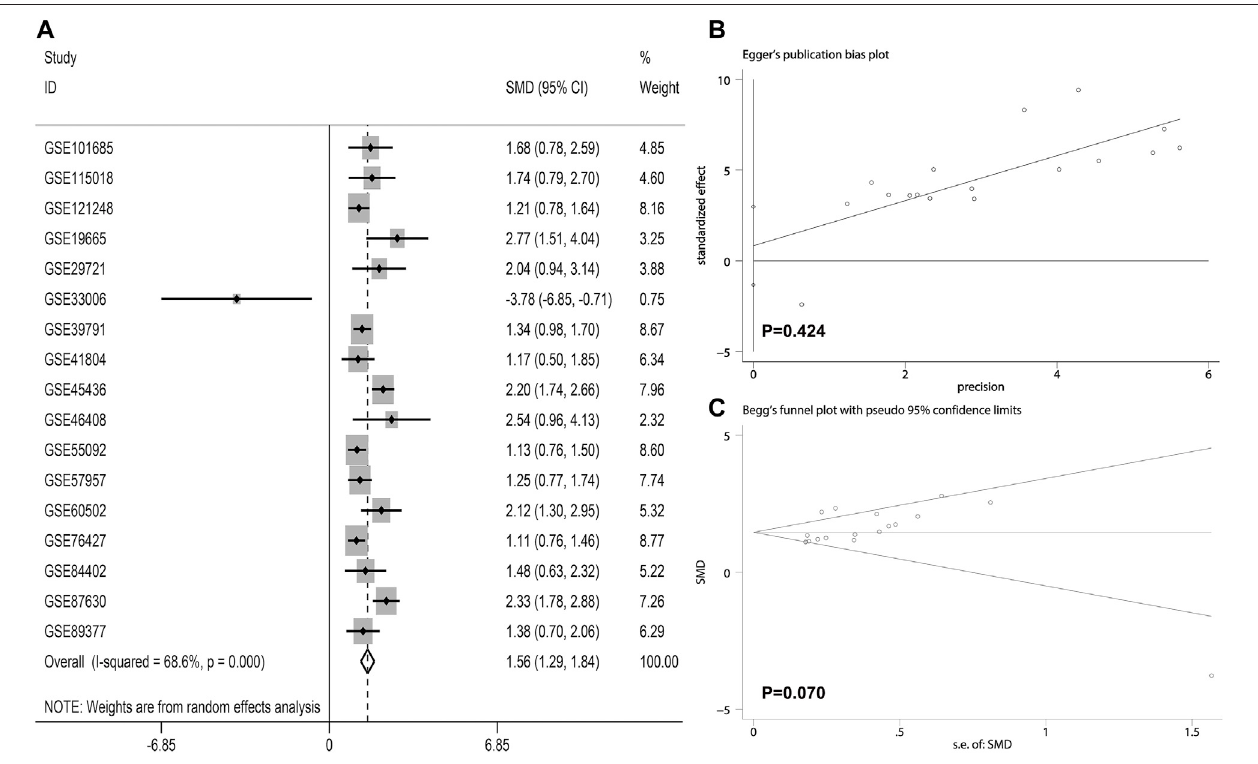
FIGURE 2 | The integrated expression of LSM4 evaluated through calculating pooled standardized mean difference (SMD) (A) ; the Egger and Begg tests to evaluate publication bias (B – C)